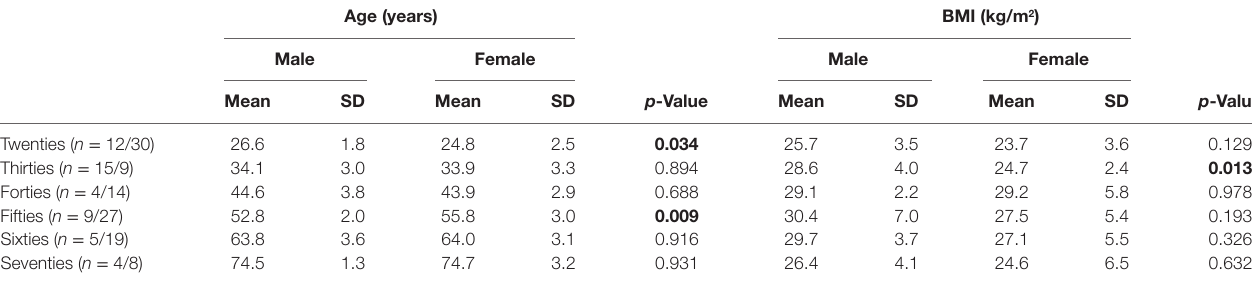
p-Values indicate differences between male and female subjects in the respective age group. Bold p-values are statistically significant (p < 0.05).